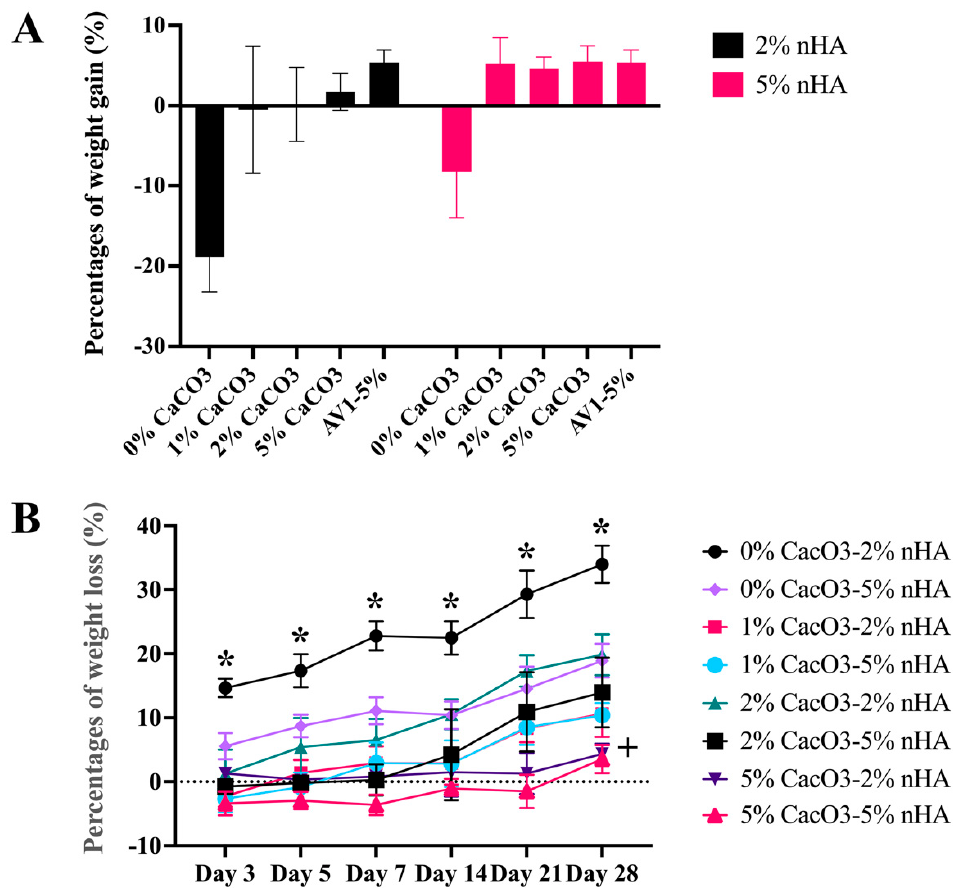
Figure 5. Effects of calcium carbonate microcapsules on physical properties of the 1%, 2%, and 5% cal- cium carbonate microcapsules-2% and 5% ( w / v ) nanohydroxyapatite-10% ( w / v ) β